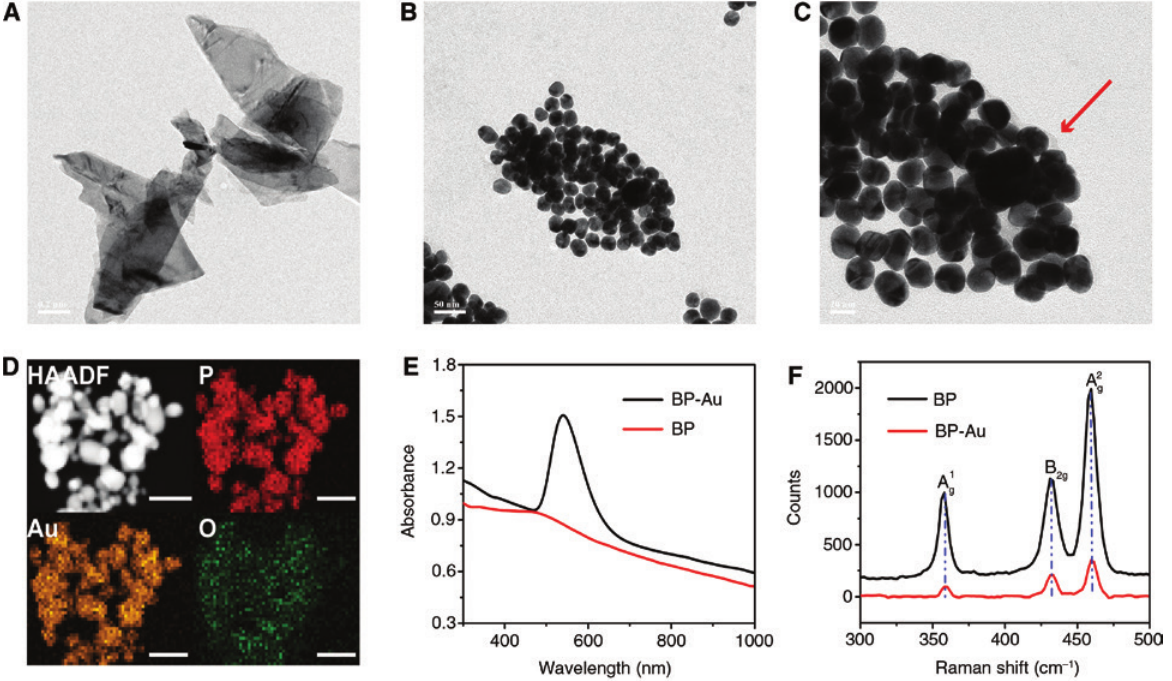
Figure 1: (A) TEM image of BP nanosheets. (B) Overall and (C) enlarged TEM images of BP-Au NSs. (D) EDX elemental mapping of BP-Au nanocomposites. (E) UV-Vis absorption spectra of the BP and BP-Au NSs at the same concentration. (F) Raman spectra of BP NSs and BP-Au